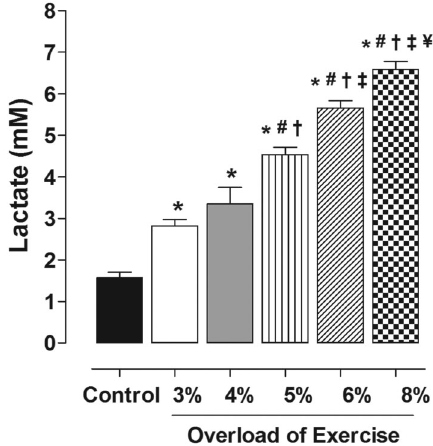
Figure 1. Lactate production as a function of exercise intensity. Data are reported as means ± SE (n=5 per group). Exercise intensity was based on loading with 3, 4, 5, 6 and 8% of body weight, respectively, during swimming exercise. *P o 0.05 vs control; # P o 0.05 vs 3%; + P o 0.05 vs 4%; = P o 0.05 vs 5%; f P o 0.05 vs 6% (one-way